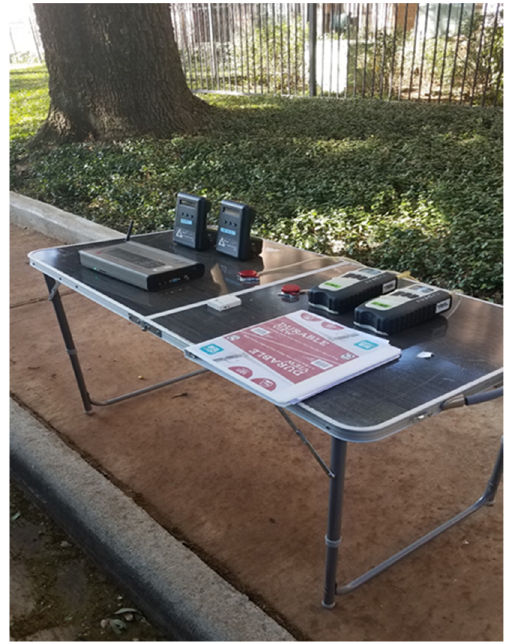
Figure 2. Sampling setup at US-59 sampling location.